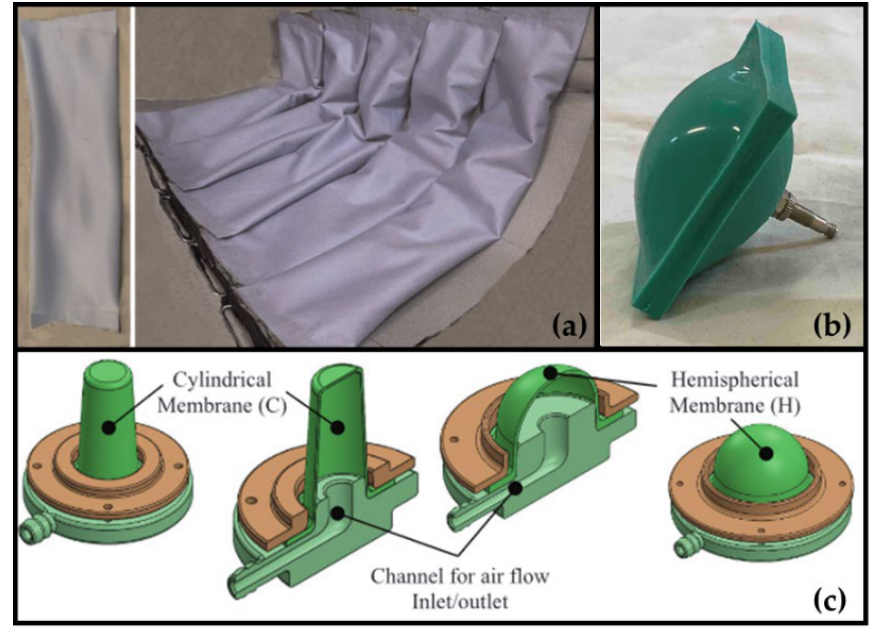
Figure 9. Air-pockets prototypes: textile [57] ( a ); silicon rubber [58] ( b ); elastomeric [59] ( c ).